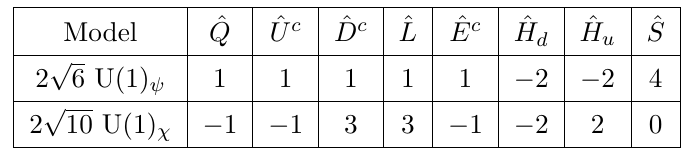
cos (cid:18) E (cid:0) Q sin (cid:18) E . i i 6 6 p v = 2, where S S